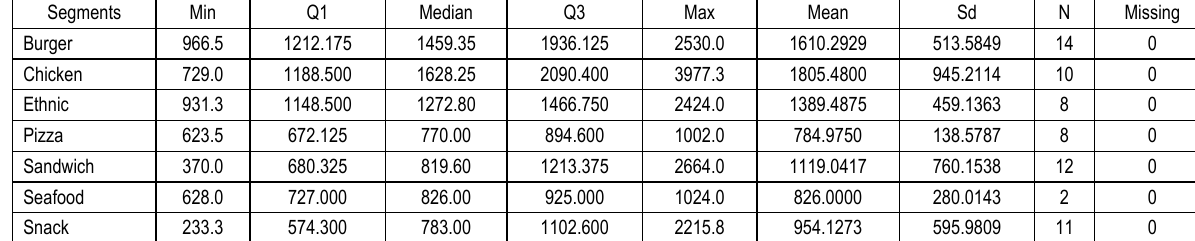
Table 3. Quick service restaurants average unit sales by segment